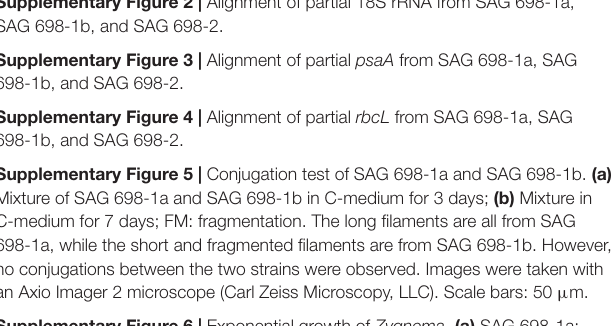
Axiovert 200M (Carl Zeiss, Jena, Germany); scale bars: 20 µ m. Supplementary Figure 2 | Alignment of partial 18S rRNA from SAG 698-1a, SAG 698-1b, and SAG 698-2. Supplementary Figure 3 | Alignment of partial psaA from SAG 698-1a, SAG 698-1b, and SAG 698-2. Supplementary Figure 4 | Alignment of partial rbcL from SAG 698-1a, SAG 698-1b, and SAG 698-2. Supplementary Figure 5 | Conjugation test of SAG 698-1a and SAG 698-1b. (a) Mixture of SAG 698-1a and SAG 698-1b in C-medium for 3 days; (b) Mixture in C-medium for 7 days; FM: fragmentation. The long filaments are all from SAG 698-1a, while the short and fragmented filaments are from SAG 698-1b. However, no conjugations between the two strains were observed. Images were taken with an Axio Imager 2 microscope (Carl Zeiss Microscopy, LLC). Scale bars: 50 µ m. Supplementary Figure 6 | Exponential growth of Zygnema. (a) SAG 698-1a; (b) SAG 698-1b. Supplementary Figure 7 | (a) Chlorophyll amount and (b) xanthophyll cycle pigments of strains SAG 698-1a and SAG 698-1b. Statistical evaluation of the chlorophyll amounts was performed with Mann–Whitney- U -test; no significant difference ( p > 0.05) was found for chl a and chl b. Supplementary Figure 8 | Stained filaments of Zygnema . (a–d) Indian ink stained cells; (e–h) Calcofluor white stained cells. Photos were taken with Zeiss Filter set 1, excitation: band pass (BP) 365/12 nm and emission: long pass (LP) 397 nm. (a,b,e,f) SAG 698-1a; (c,d,g,h) SAG 698-1b; Images were taken with a Zeiss Axiovert 200M (Carl Zeiss, Jena, Germany); scale bars: 20 µ m. Supplementary Figure 9 | Confocal laser scanning images of Zygnema ; (a,b) SAG 698-1a; (c,d) SAG 698-1b; Images were taken with a Zeiss Axiovert 200M, Pascal LSM5 (Carl Zeiss, Jena, Germany); scale bars: 20 µ m. Supplementary Figure 10 | Microscope image of SAG 698-1a and SAG 698-1b filaments plasmolyzed and digested with cell wall enzymes. Images were taken under Axio Imager 2 microscope. (a,b) SAG 698-1a; (c,d) SAG 698-1b. Scale bar in (a) : 50 µ m, in (b–d) : 20 µ m. Supplementary Table 1 | PCR primers used for sequencing. Supplementary Table 2 | Measurements of cell diameter and mucilage sheath width, Q = quartile; IQR = inter quartile range; SD = standard deviation, SE = standard error. Supplementary Table 3 | HPLC pigment analysis of SAG698-1a and SAG698-1b, Statistical level of significance of the pigment amounts (Mann–Whitney- U -test); ∗ p < 0.05; ∗∗ p < 0.01; ∗∗∗ p <